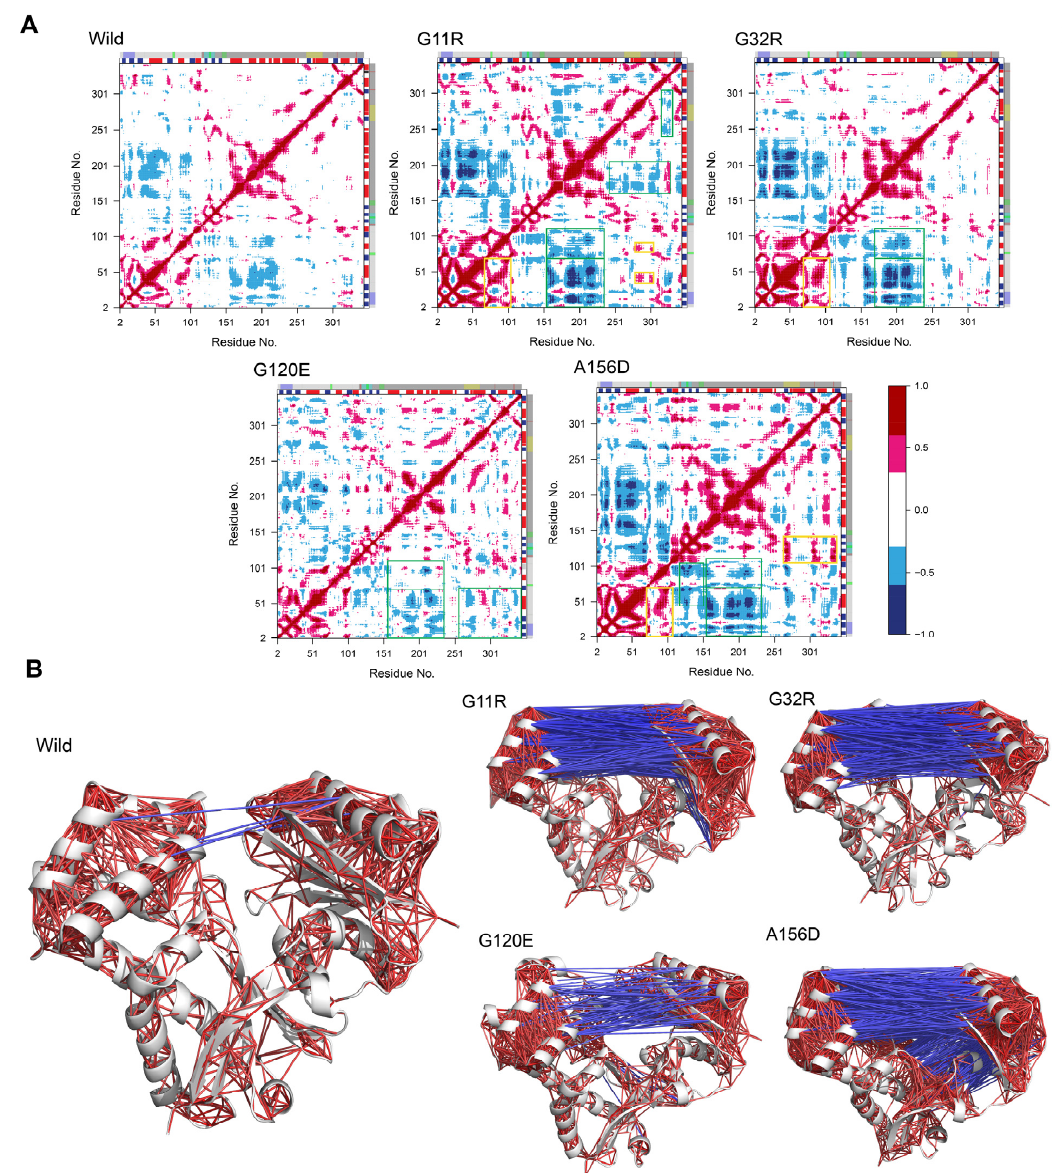
Figure 6. Effect of variants in the NAGK correlated motions. ( A ) Two-dimensional DCCM plot represents residual correlative motion by a color-coded heat map, where red denotes correlated motion between two residues, while blue indicates motion in an anti-correlated manner. Here, the color-coded bar from red to blue denotes the degree of correlation from 1 to − 1. Either yellow or green boxes mark a specific area with positive and negative correlation in each map. On the other hand, the secondary structural elements (SSE) and domain organization are represented as the colored bars at the top and right of the map. The details of domain organization are discussed in Figure 5. Red and blue color in the SSE bar represents alpha-helix and beta-sheet, respectively. ( B ) Strongly correlative motion is represented by NAGK cartoon representation, where red lines indicate strongly correlated (6 to 8) motions, and blue are anti-correlated ( − 8 to − 6) motions. Again, to expose the changes in protein dynamics, we conducted principal compo- nent analysis (PCA), representing most of the dominant motions during the simulations [17,29]. Remarkably, all variants were found to have more variances than that of the wild- type, such as G11R, G32R, G120E, and A156D with variances of 60.9%, 53.9%, 53.9%, and 58.8%, respectively, in the first three PCs, whereas wild-type has a variance of 43.2%. All